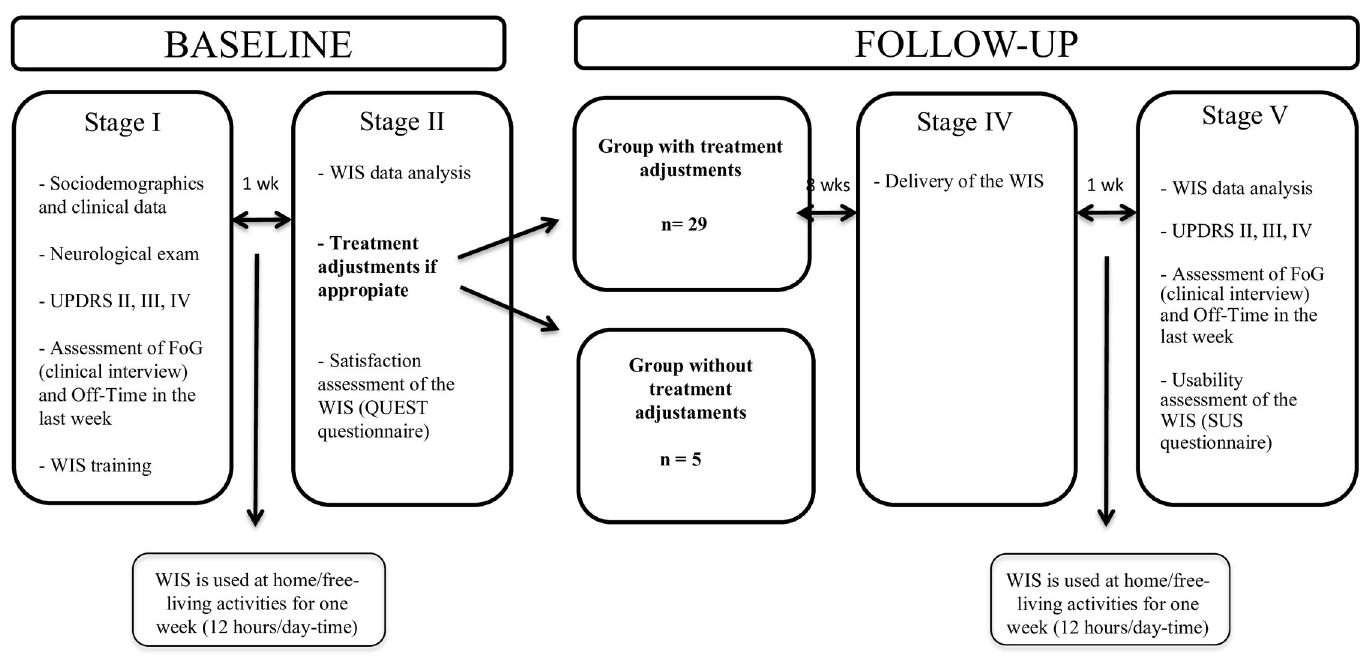
Fig 2. Design, procedures, and clinical